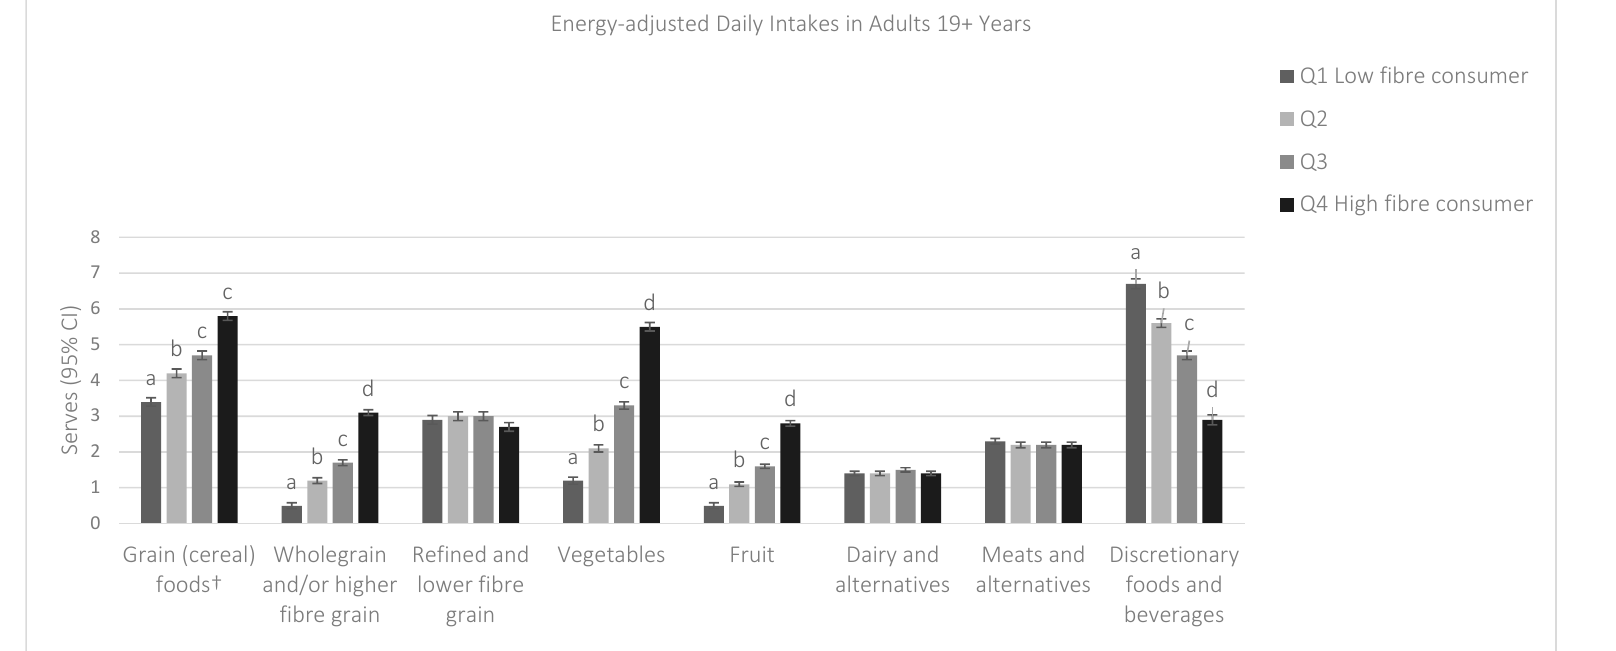
Figure 2. Energy-adjusted mean daily serves among adults 19 years and over from the Australian Dietary Guidelines five food groups and discretionary foods and beverages by quartile of fibre intake. a, b, c, d denote significant difference between quartiles ( p < 0.001). Marginal mean serves from general linear models adjusted for energy intake. † Includes wholegrain and/or higher fibre grain, and refined and lower fibre grain.